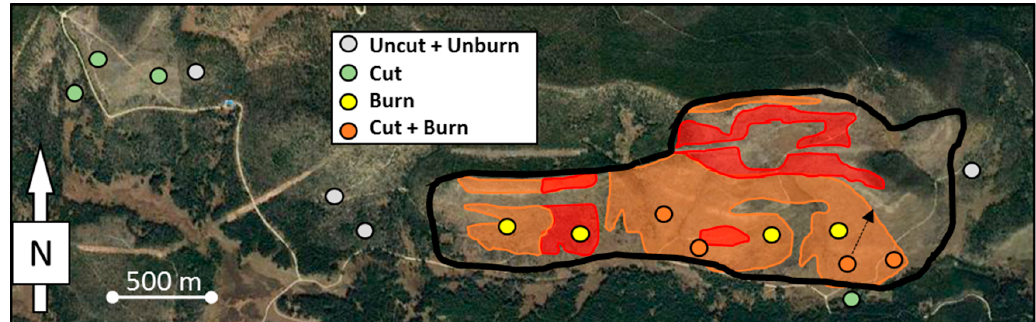
Figure 2. Perimeter of the Church’s Park Fire and surroundings, near Fraser, Colorado, denoting areas mapped with moderate- ( orange ) and high- ( red ) burn severity and centers of operational-scale study sites. Unshaded areas within the fire perimeter were burned at low-severity. The dashed arrow is oriented with the general views in Figure 1. Aerial photo image date is 9 October 2015, five years after the fire. Image Citation: Google Earth Pro V7.3.1.4505 (Google LLC, Mountain View, CA, USA); accessed 2 February 2018.